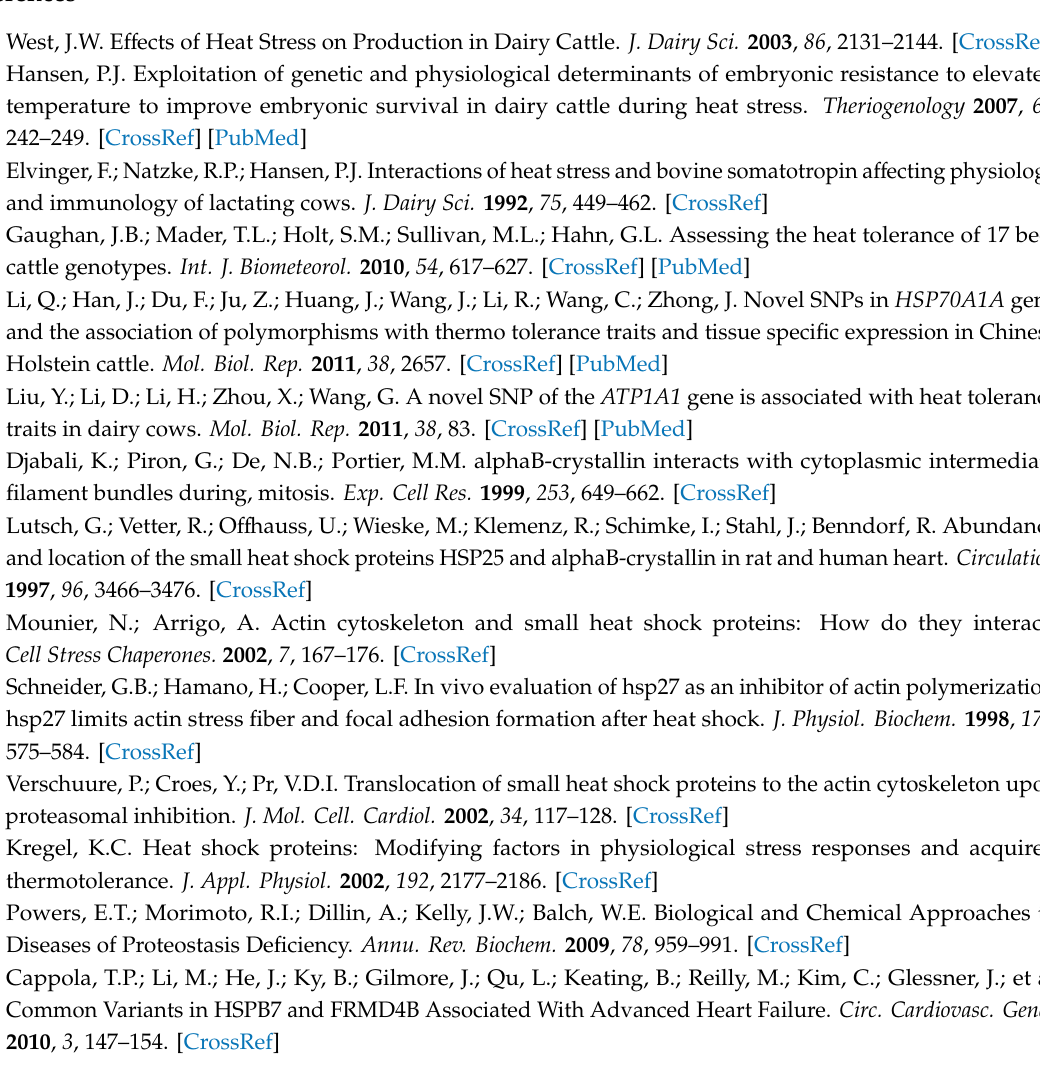
Table S1: The distribution of 32 cattle breeds of China as well as Angus and Zebu population; Table S2: Primer sequences and fragment size for PCR amplification of the HSPB7 gene; Table S3: Genotypic and allele frequencies of the HSPB7 gene across 34 cattle breeds; Table S4. Test of three subjects e ff ects on HSPB7